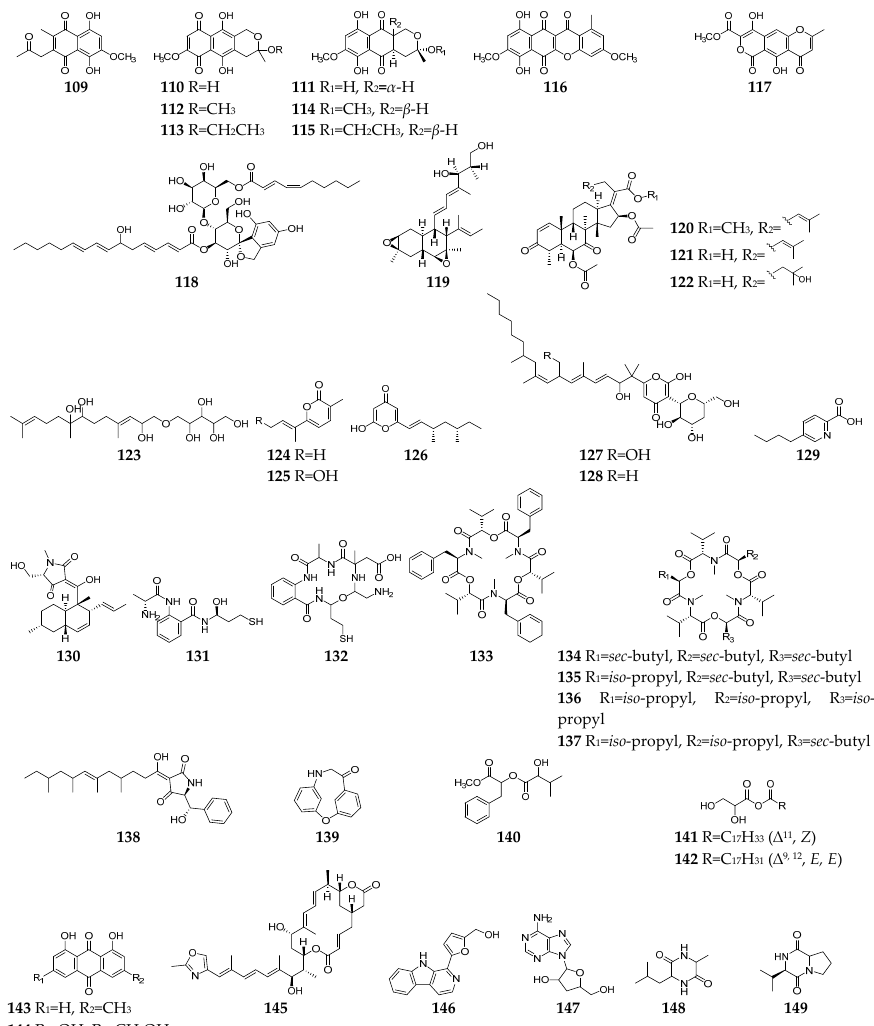
Figure 5. Fusarium -derived antibacterial and antifungal SMs ( 109 – 149 ). Compounds 124 – 128 are pyrone family members and showed antimicrobial activ- ity against bacteria (such as B. subtilis , S. aureus , Vibrio parahaemolyticus , C. kefyr , and P. aeruginosa ) and fungi (such as A. clavatus , Geotrichum candidum , C. albicans , M. albican , and S. cerevisiae ) [47,71–74]. Fusaric acid ( 129 ), one of the most significant mycotoxins from Fusarium strains, displayed a broad spectrum of moderate antimicrobial activity against Bacillus species, Acinetobacter baumannii, Phytophthora infestans , etc. [75–77]. Equi- setin ( 130 ) was shown to be active against several strains of Gram-positive bacteria ( B. subtilis , Mycobacterium phlei , S. aureus , methicillin-resistant S. aureus , and S. erythraea )